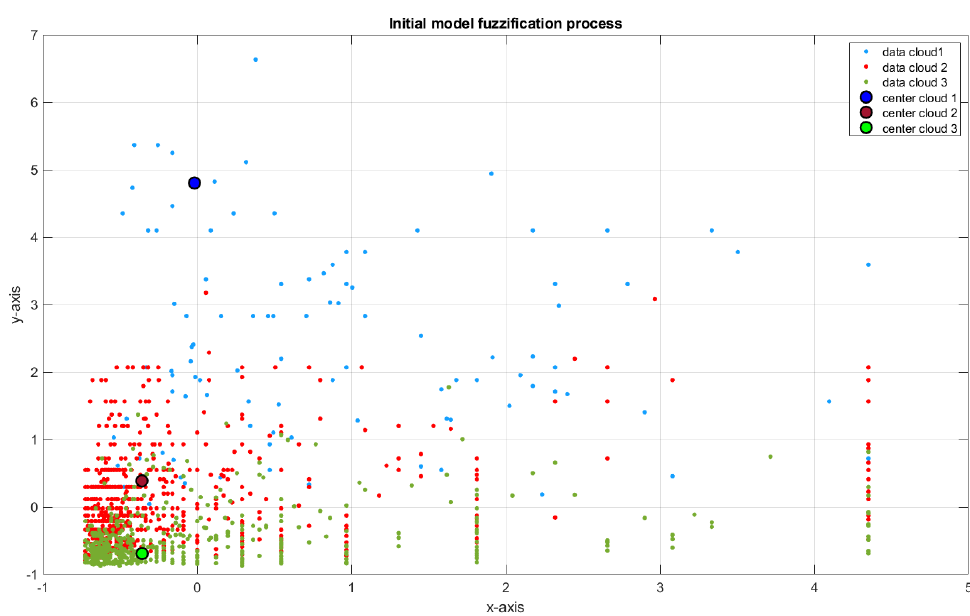
Figure 10. Evaluation of overlapping of the three generated fuzzy neurons during the fuzzification process: successive outbidding versus bidding ratio.